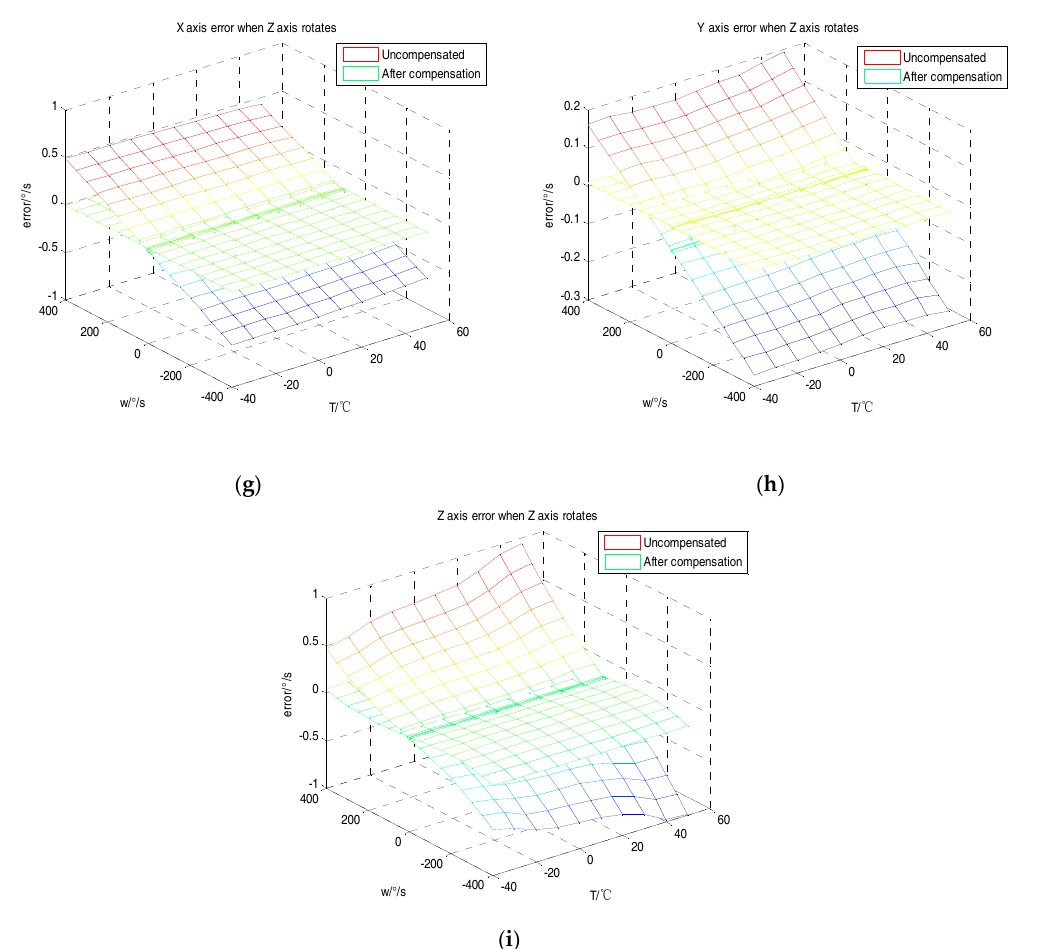
Figure 7. Error distribution before and after compensation. ( a ) Error distribution of the X-axis when the X-axis rotates; ( b ) error distribution of the Y-axis when the X-axis rotates; ( c ) error distribution of the Z-axis when the X-axis rotates; ( d ) error distribution of the X-axis when the Y-axis rotates; ( e ) error distribution of the Y-axis when the Y-axis rotates; ( f ) error distribution of the Z-axis when the Y-axis rotates; ( g ) error distribution of the X-axis when the Z-axis rotates; ( h ) error distribution of the Y-axis when the Z-axis rotates; ( i ) error distribution of the Z-axis when the Z-axis rotates. Mean and Root Mean Square (RMS) error is used as a direct comparison here. From the data